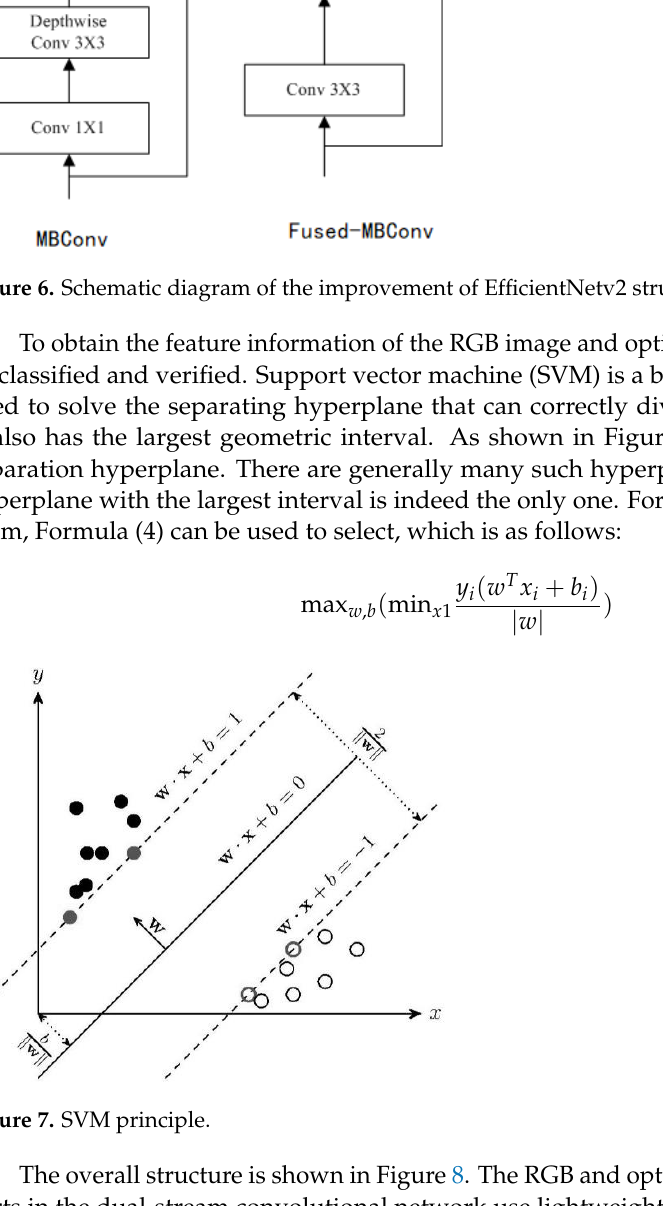
8 of 23 Figure 5. Two-stream convolutional network structure. The extraction of optical flow images in the network (action video preprocessing) is obtained by gradient-based operations. The key principles of the algorithm (1) are as fol- lows: first, set the image sequence I(x, y, t) ; the vector X = [x, y] . The sequence is extracted from the previous and subsequent frames in a demo video, that is, when the local optical flow image of the video is basically constant. For any Y ∈ N(x) , there are: (